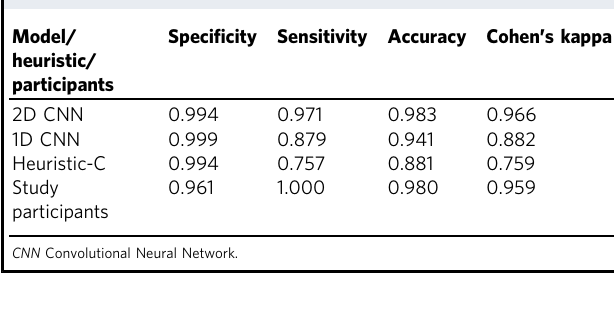
Table 3 Results of classi fi cation experiment 2 (CE2), including the performance of the 2D CNN trained in experiment 1 (CE1), on dataset 4 ’ s test set with more weak positive results ( N = 237).